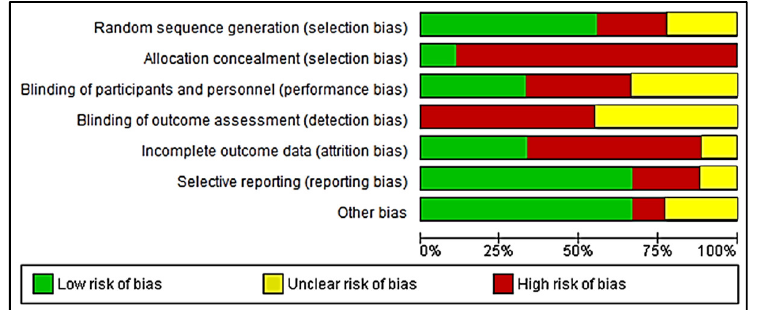
Figure 4. Risk of bias graph.